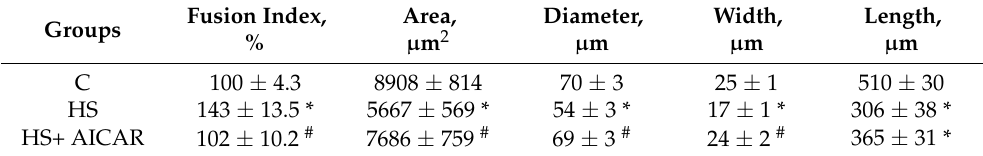
Table 3. Morphological characteristics of differentiating myoblasts derived from the atrophied rat soleus muscle. Values are means ± SEM. The fusion index was calculated as the percentage of nuclei in fused myotubes out of the total nuclei, measured in %. C—myoblasts derived from rat soleus muscle of the control rats, HS—myoblasts derived from rat soleus muscle after 7-day HS, HS+AICAR—myoblasts derived from rat soleus muscle after 7-day HS and treated with AICAR; n ≥ 36/group. *—significant difference vs. C, p < 0.05, #—significant difference vs. HS, p < 0.05. Fusion Index, Area, Diameter, Width, Groups µ m 2 % 100 ± 4.3